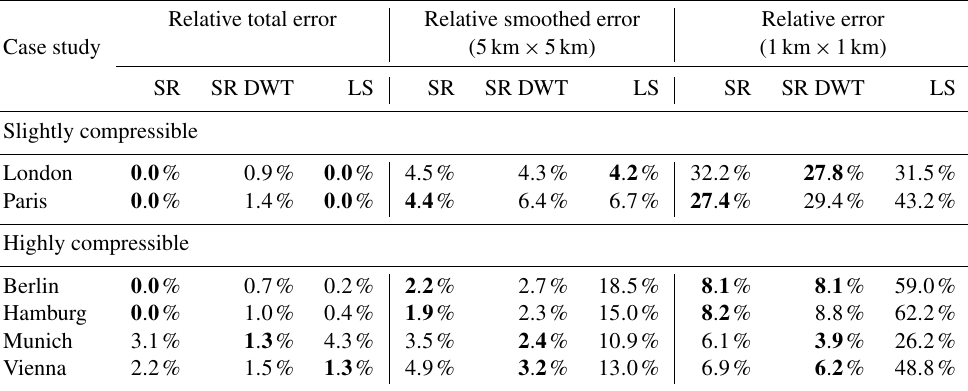
≈ 1 . 5 with an SNR of 20.0dB n